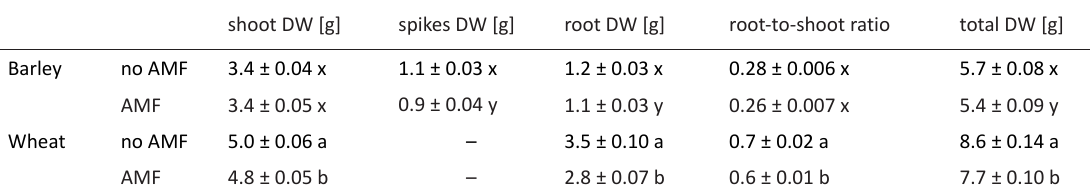
Data represent means ± SEM. Different letters indicate significant differences at p <